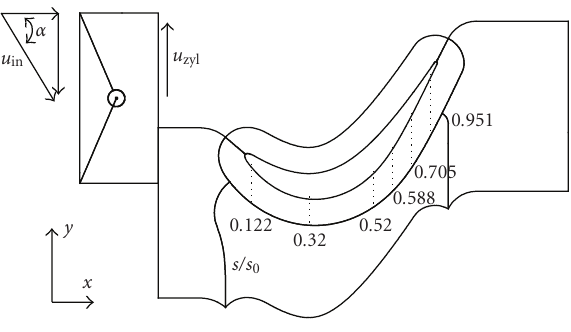
Figure 4: Computational domain and measurement positions.